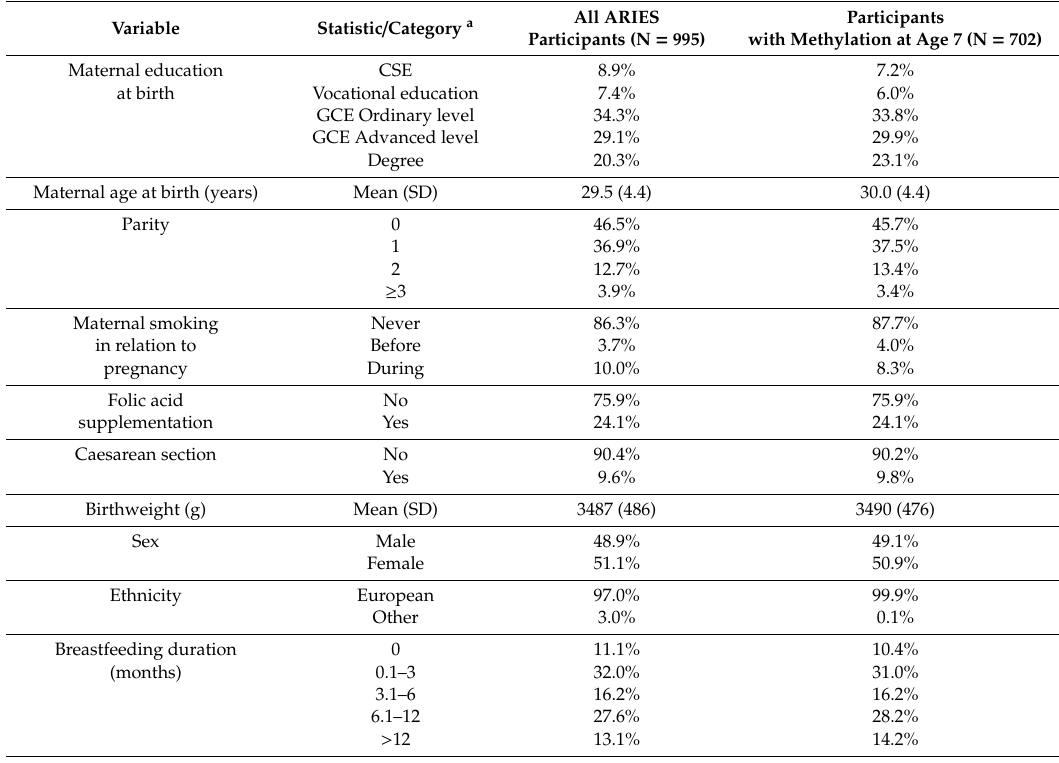
Table 1. Description of the individuals included in the main analysis (ARIES participants with age 7 methylation data and all